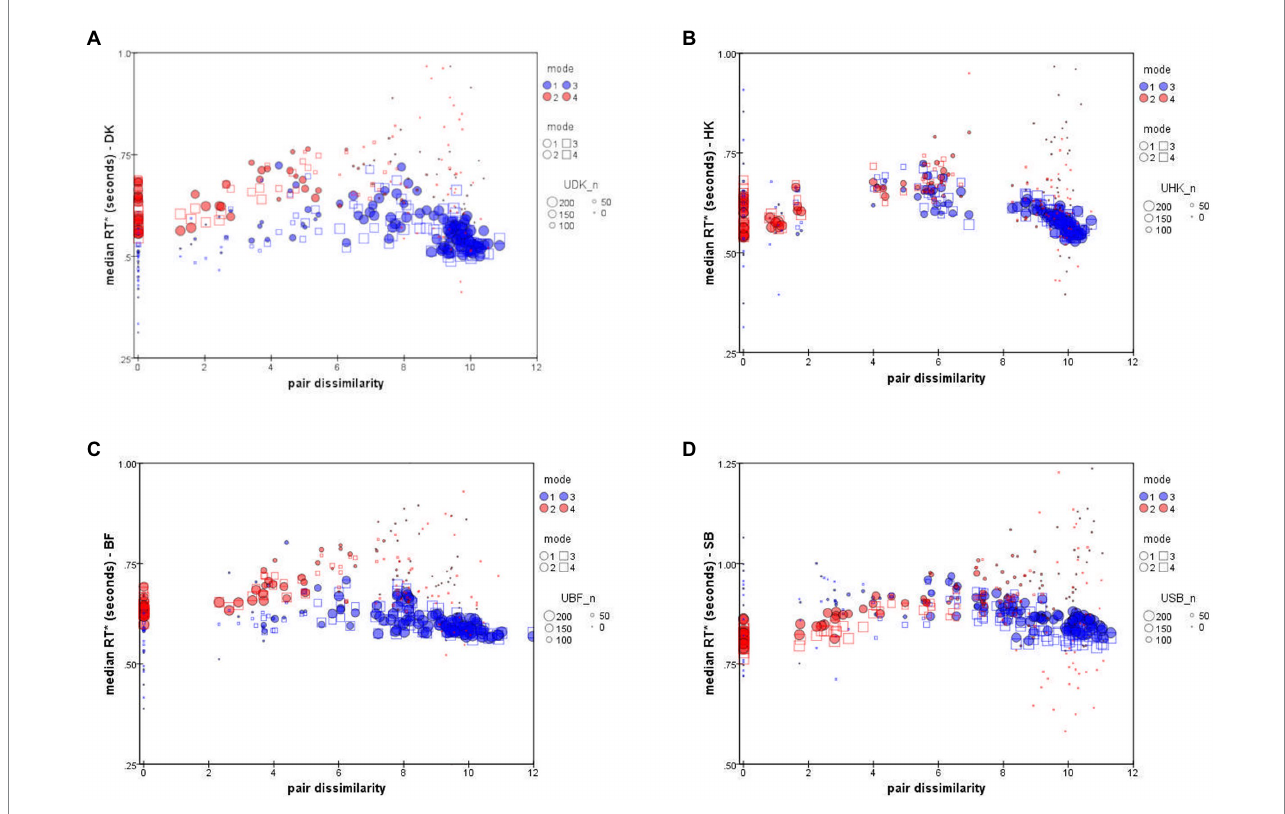
FIGURE 6 Median RT* of “Same” responses, M S ij (red symbols), and “Different” responses, M D ij (blue symbols), as a function of distance in the accuracy-rate based MDS solutions. ● = Upright mode; □ = Inverted mode. Symbol size represents number of responses to pair ( i,j ). Data for individual participants: (A) DK, (B) HK, (C) BF, (D) SB (note difference in the y -axis